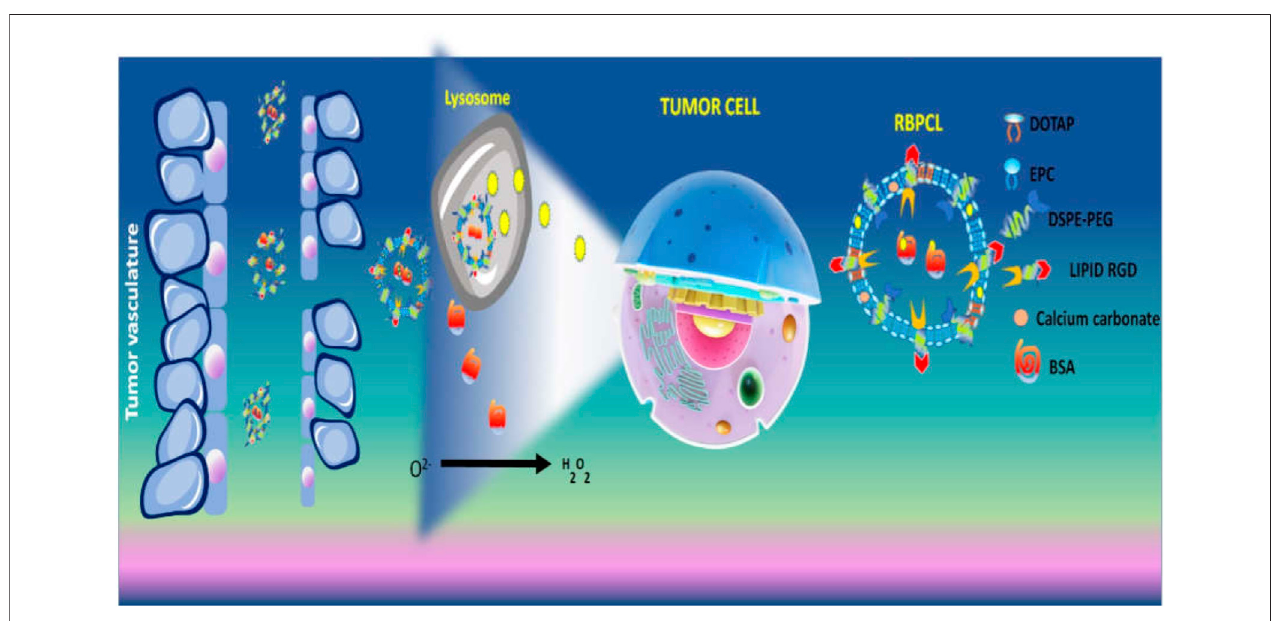
FIGURE 5 | Schematic illustration of pH dependent drug release from CaCO 3 nanoparticles containing BSA and PTX.